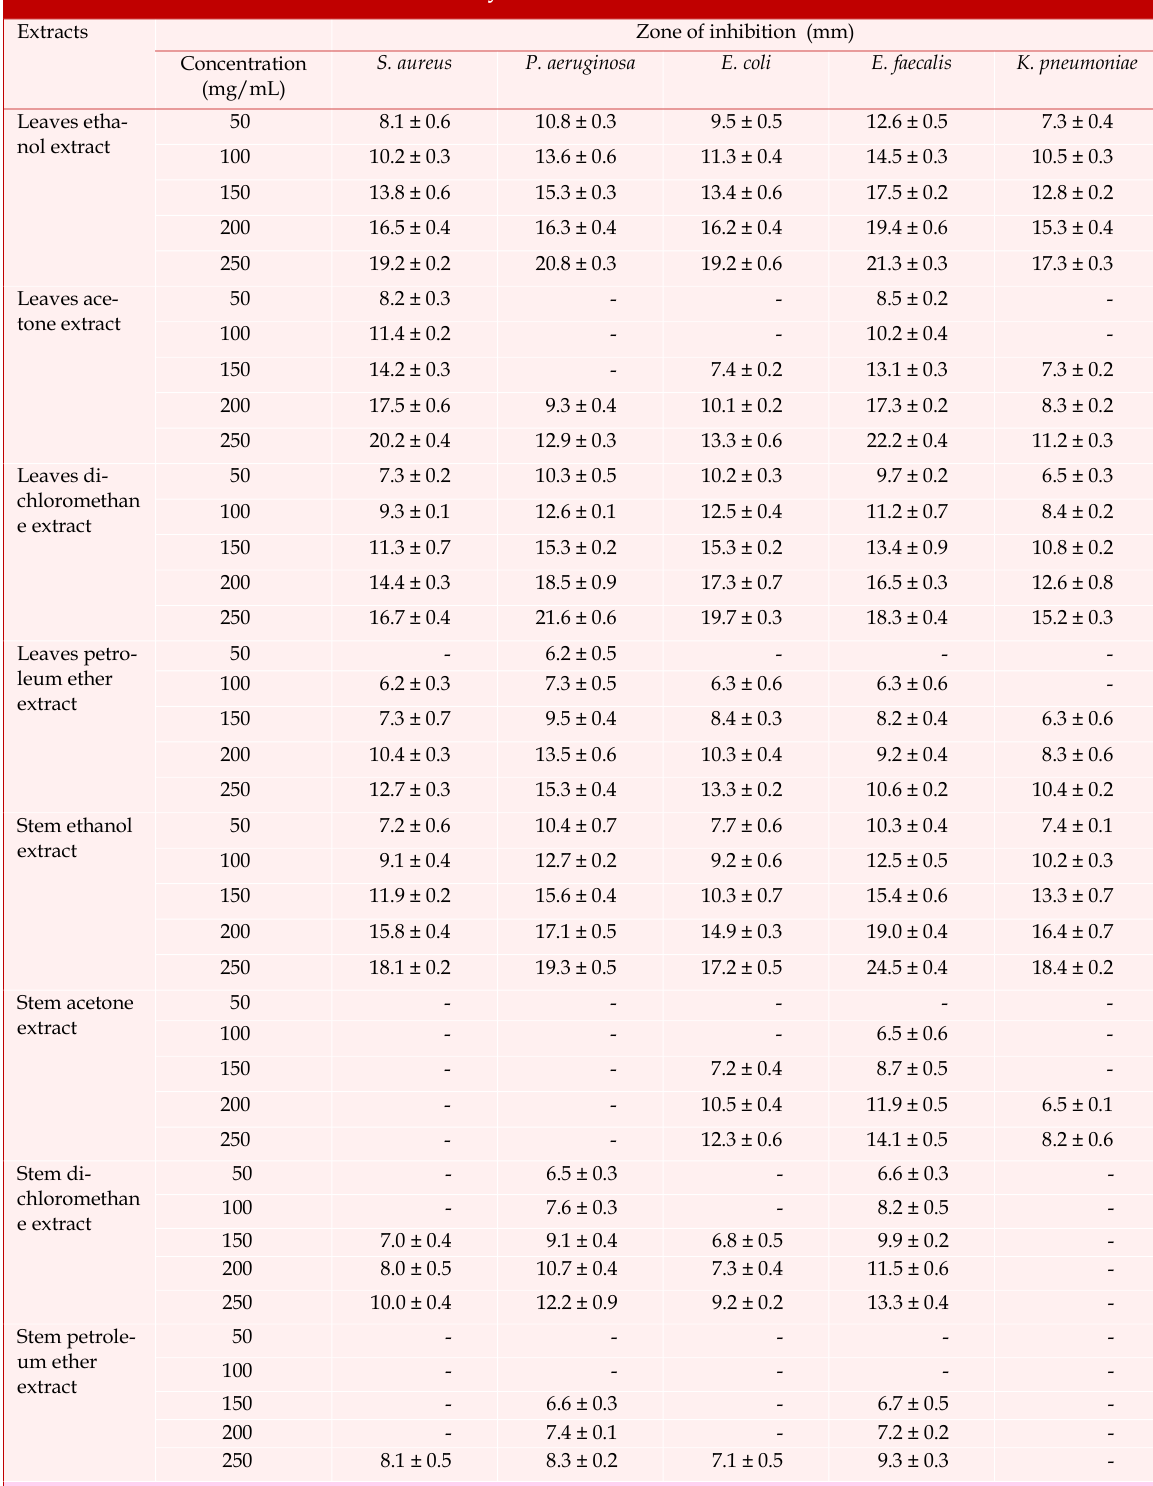
Antimicrobial activity of E. linneanum leaf and stem extracts